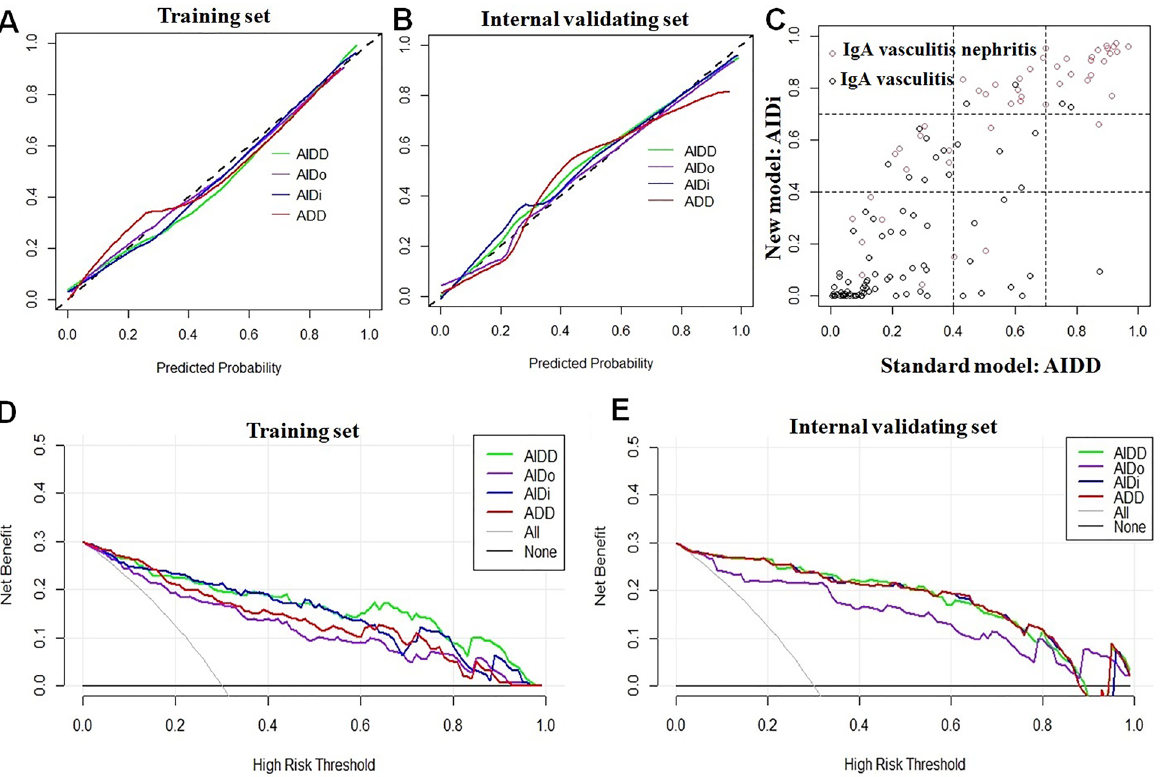
Figure 2. Model calibration and discrimination of 4 combined model for predicting the risk of IgA vasculitis nephritis. Calibration plot ( A , B ), net reclassification index ( C ) and decision curve analysis ( D , E ). IgA vasculitis nephritis.